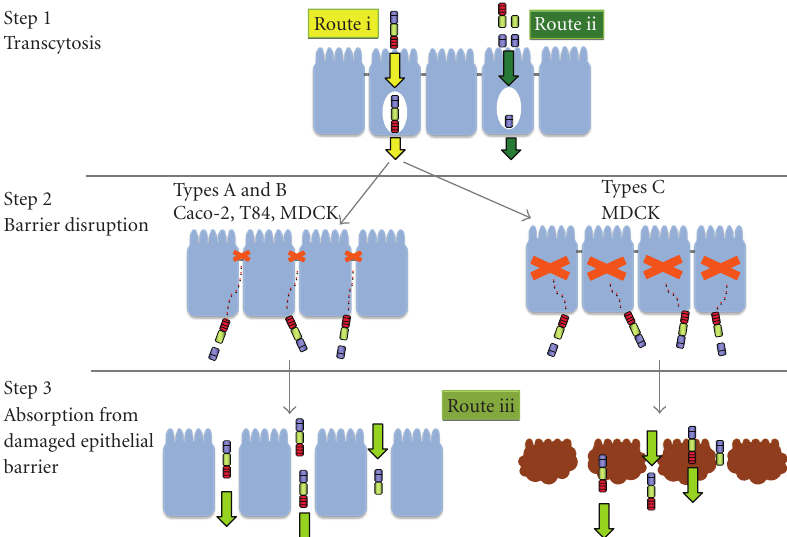
Figure 3: Model for penetration of BoNT complexes through the intestinal epithelial barrier. Step 1: HA of the BoNT complex mediates binding and transcytosis of a small amount of luminally located BoNT complexes across the epithelium without disrupting the epithelial barrier (Arrows in yellow, “route i”) [65]. H chain of BoNT also mediates binding and transcytosis of BoNT (Arrows in green, “route ii”) [61–66]. Step 2: HA which has translocated on the basolateral surface disrupts the epithelial barrier. Types A and B HA proteins disrupt the paracellular barrier of without causing cytotoxic e ff ects in the epithelial cells of their susceptible hosts [65, 77]. Type C HA proteins possibly evoke cytotoxic-barrier disrupting activity in the epithelial cells of susceptible animals [77]. Step 3: A large amount of the BoNT complexes and BoNT accumulates in the serosal side by passing from the damaged epithelial barrier (Arrows in light green, “route iii”)